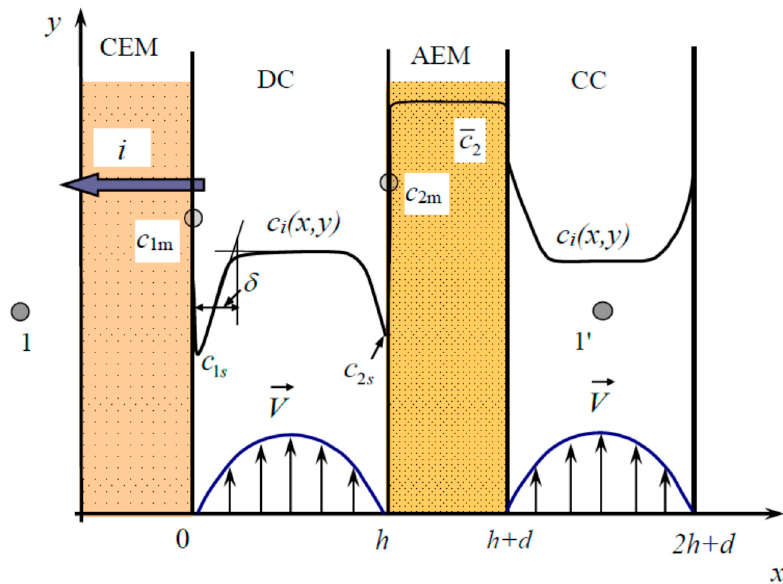
Figure 8. Scheme of an ED cell with an AEM and a CEM; DC and CC are the desalting and concentrating compartments, respectively. The points 1 and 1 ′ show where the tips of Luggin’s capillaries are placed for measuring PD. Redrawn from [4].